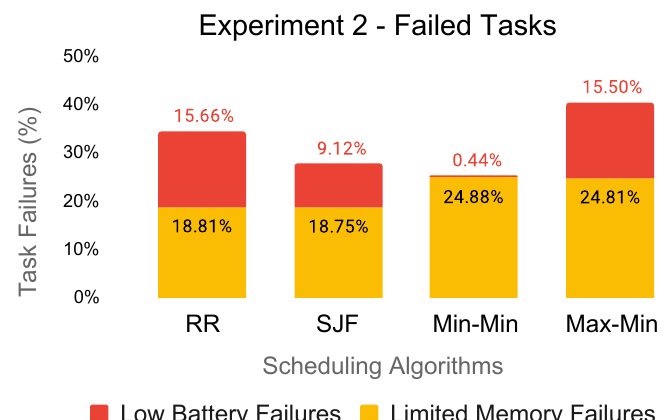
Figure 5. Percentage of failed tasks for Experiment 2 (8000